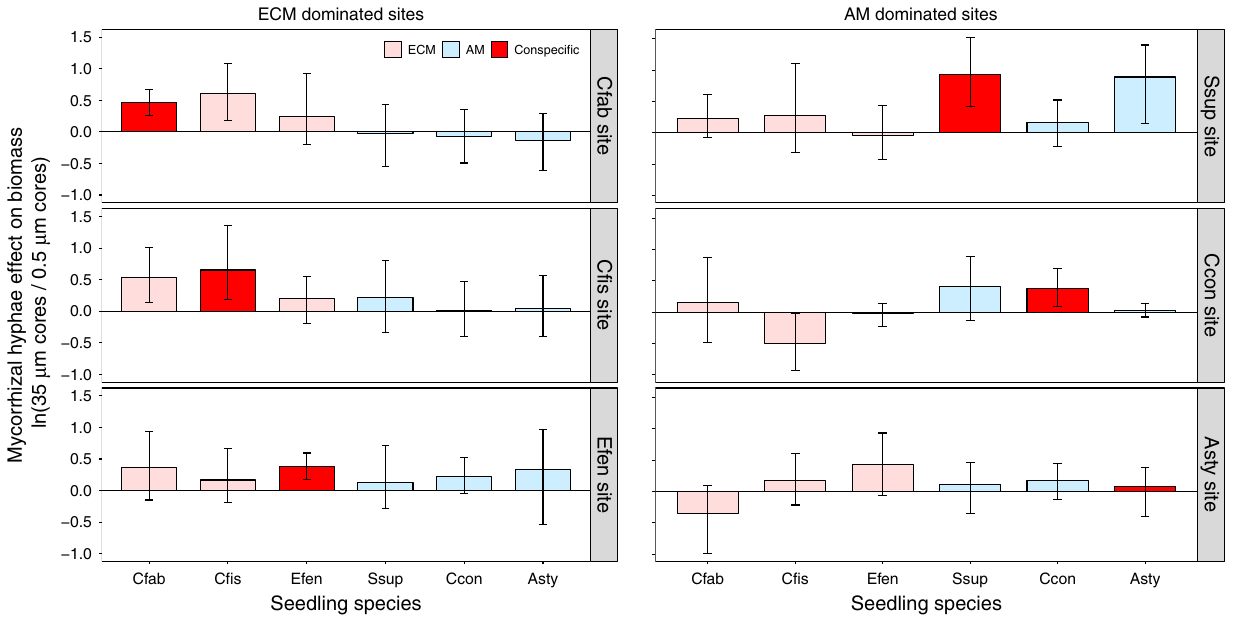
Fig. 3 Effects of mycorrhizal hyphal connections on seedling growth at ECM or AM dominated sites. Left panels: ECM dominated sites. Right panels: AM dominated species. Pink: ECM tree species; Light blue: AM tree species; Red: tree species at sites dominated by conspeci fi c adults. Species studied were: Castanopsis fabri (Cfab), Castanopsis fi ssa (C fi s), Engelhardia fenzelii (Efen), Schima superba (Ssup), Cryptocarya concinna (Ccon), and Artocarpus styracifolius (Asty). Values represent log response ratios and associated 95% con fi dence intervals, which compared seedling mean biomass of in-growth cores with 35 µ m vs. 0.5 µ m mesh in the growth experiment ( n = 6 biologically independent seedlings for each treatment).